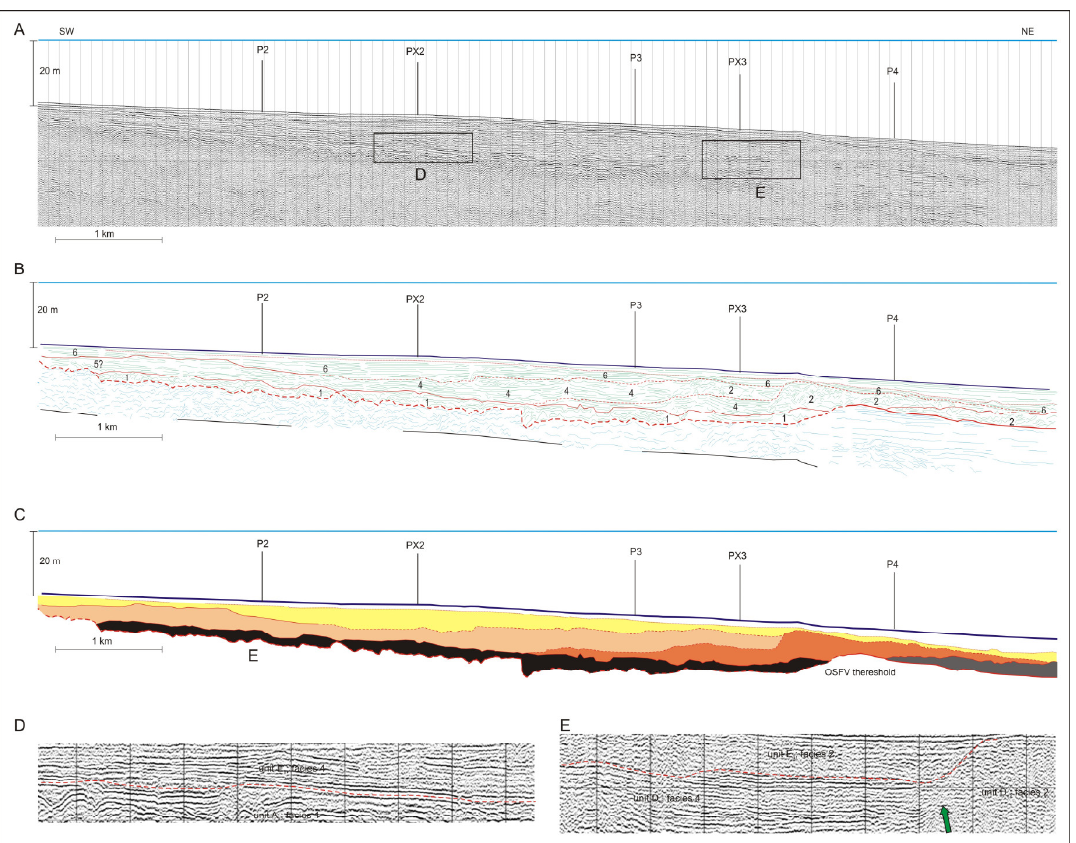
Figure 12. Part of seismic profile T4. Seismic section ( A ), interpretation ( B ), seismic unit recognised ( C ), and enlargement of some significant sectors of the unconformities between units and, with some transitions between different seismic facies within some units ( D,E ). In this profile we note the seismic facies 4 which characterises the backbarrier deposits of both unit D u and unit E u , as well as the smaller width of the central bodies (seismic facies 2a) of unit D u and unit E u , with respect to seismic profile T5 (Figure 9).